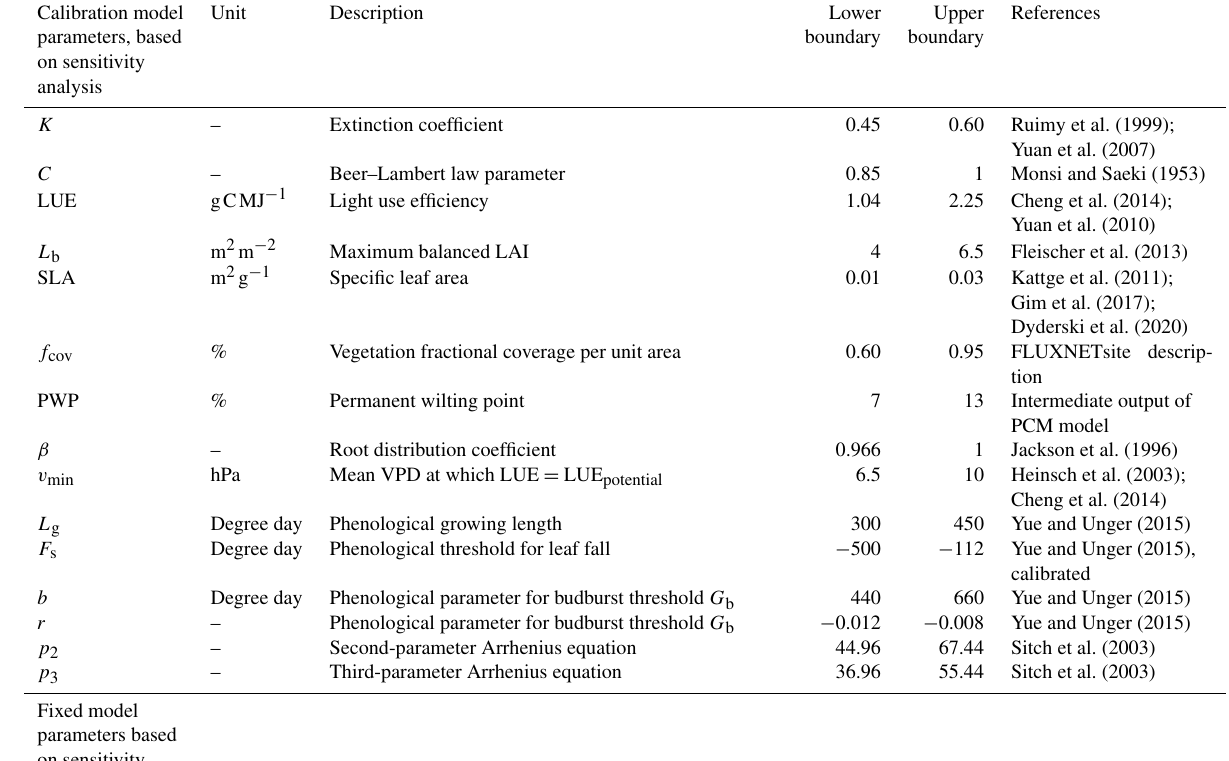
Table 3. Model parameters in PCM. Calibration model